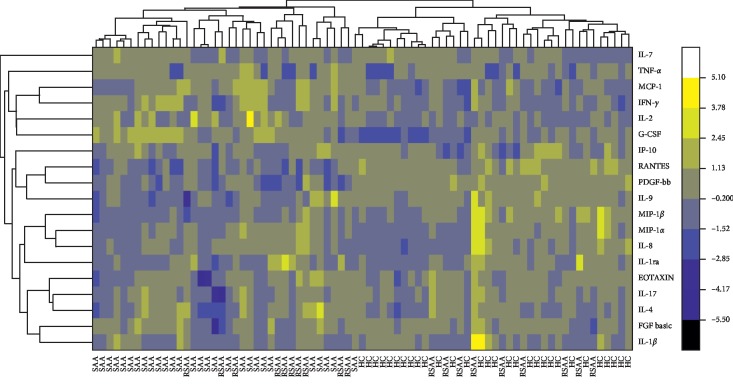
Different cytokine profiles of severe aplastic anemia (SAA) patients, recovering SAA (RSAA) patients, and healthy controls (HCs). A two-way hierarchical cluster analysis was performed on the log-transformed cytokine levels of SAA, RSAA, and HC samples using OriginPro 2018. Color scales represent cytokine levels (yellow indicates high levels; blue indicates low levels). The dendrogram above the figure was categorized into three clusters according to the cytokine profiles. The dendrogram to the left of the figure displays the proximities of the cytokines.